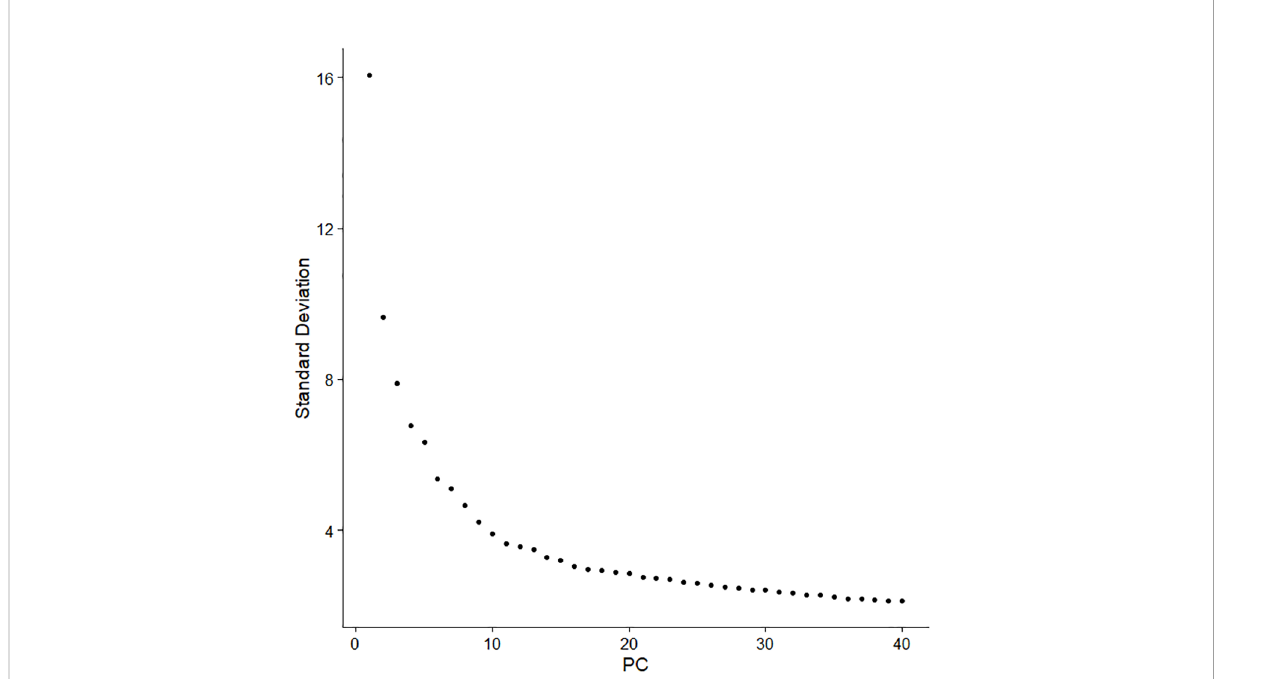
FIGURE 3 The elbow plot of the principal component